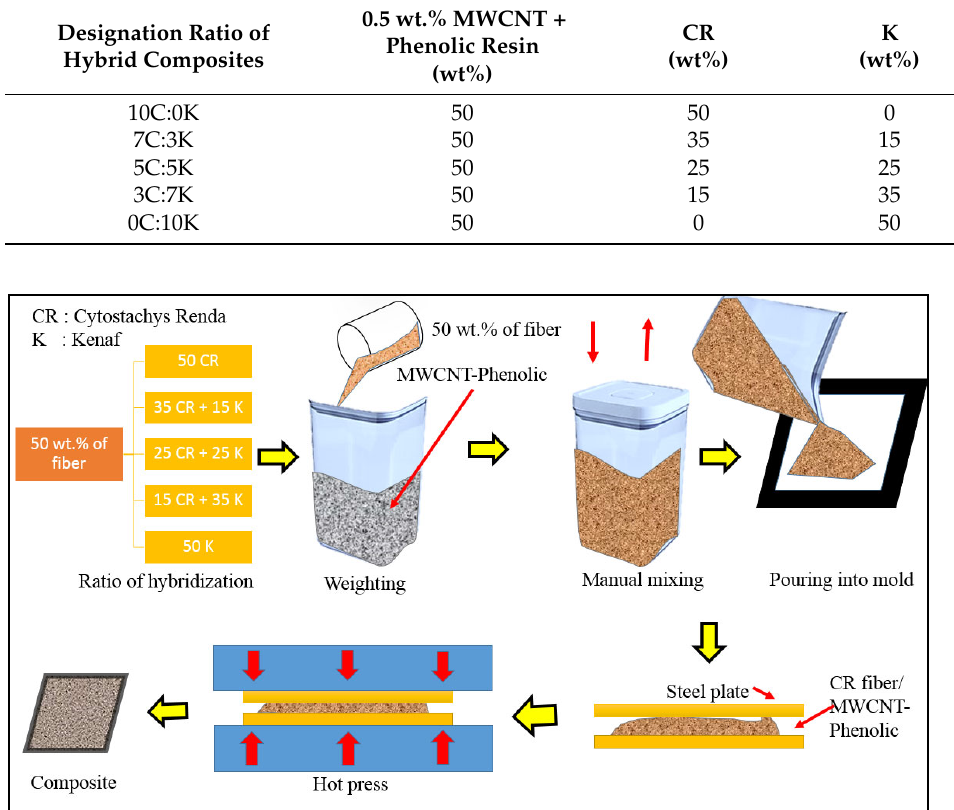
Figure 1. Schematic diagram of hybrid composite preparation.